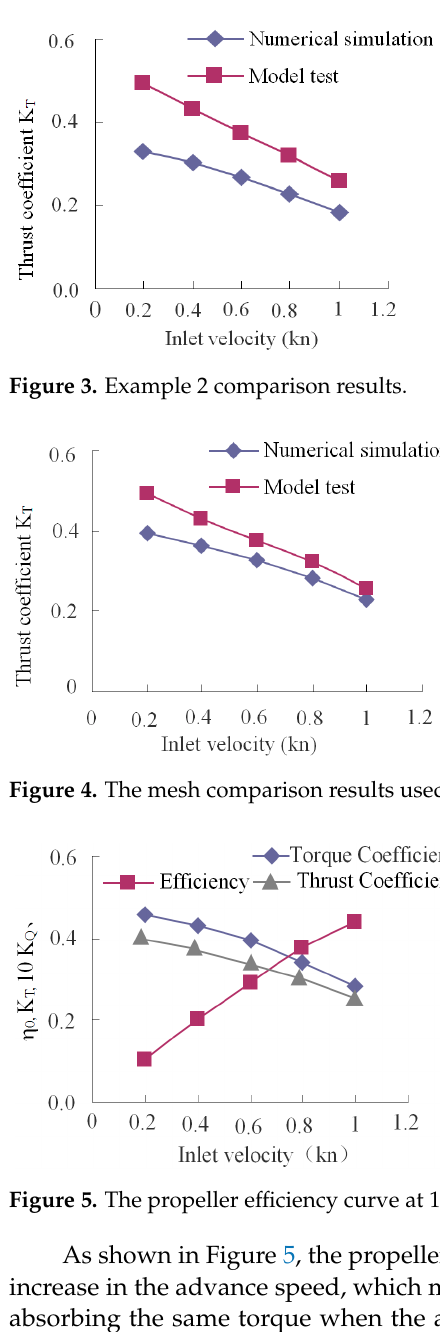
Figure 6. Rotation speed at 500 rpm.